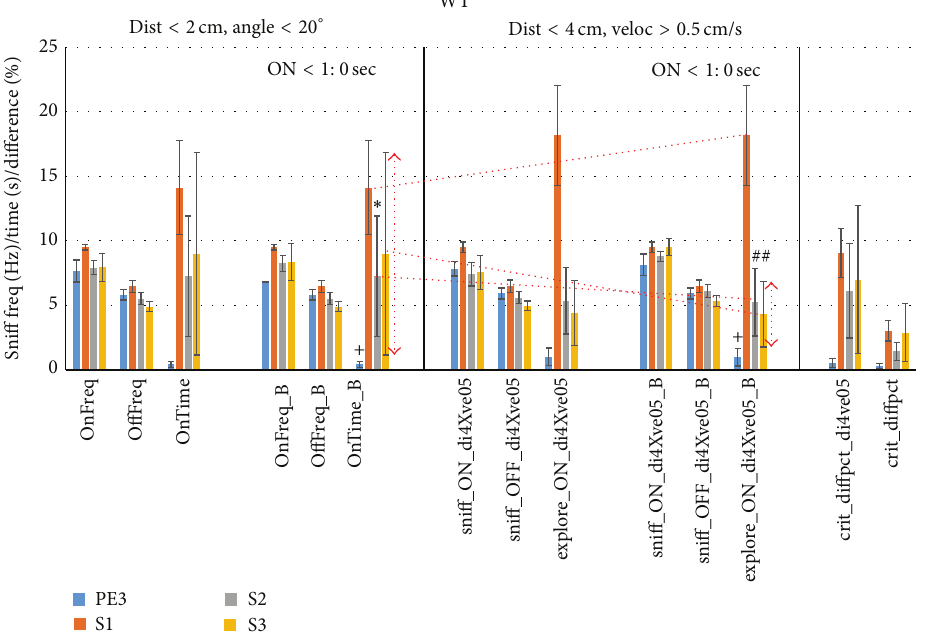
Figure 12: New combined proximity-velocity criterion improves HaXha exploration scoring in WT mice. To test the usefulness of the exploration criterion of the velocity > 0.5 cm/s and distance < 4cm, the trials were scored accordingly (center) for sniff rate (Hz) when exploring (sniff ON di4Xve05) or not (sniff OFF di4Xve05) and exploration time (s; explore ON di4Xve05). The results of the standard criterion( 𝑑 < 2 cmandangle < 20 ∘ )areshownontheleft(sameasFigure 1,left).Dataweremorerobustuponremovingsniffratesofmicewith exploration time < 1sec ( B extension). The new criterion increased S1 exploration time (orange line) and decreased S2 and S3 exploration time variance (arrows), while retaining high sniff rates indicative of sniff-guided odorant exploration, leading to stronger statistical conclusions. The difference (%) in time bins meeting these two criteria was also assessed (% overlap; crit diffpct div4ve05) as well as between the Noldus distance-angle exploration marker output and the thresholded smoothed distance-angle score (crit diffpct). ∗ 𝑃 < 0.05 ; + 𝑃 < 0.01 ; # 𝑃 < 0.001 (paired 1-sided 𝑡 -test versus